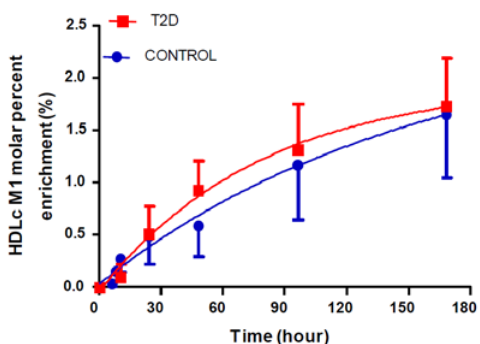
Figure1. High-densitylipoproteincholesterolturnoverinT2Dpatients(n = 9)andage-andBMI-matched healthy controls (n = 8) determined using a 2 H 2 O-metabolic labeling approach. A steady-state body water enrichment (~0.8–0.9%) results in gradual labeling of HDL cholesterol, which enables quantification of its turnover rate. Data presented as mean ± SD. Table 2. High-density lipoprotein (HDL) cholesterol kinetic parameters in subjects with T2D (n = 9) and age- and body mass index (BMI)-matched healthy controls (n =